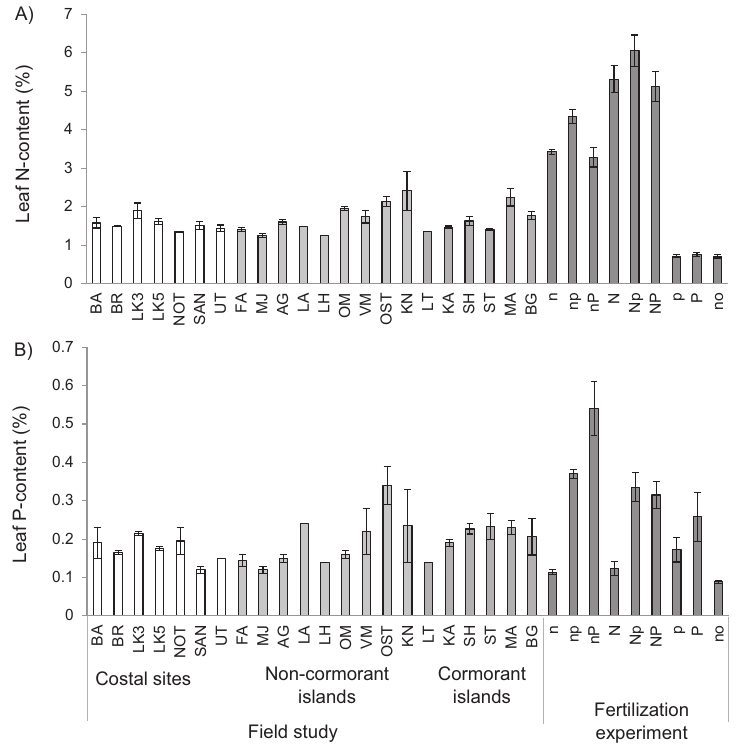
Figure 3. Lythrum salicaria leaf N- and P-contents collected on field costal field sites, non-cormorant islands, abandoned and active cormorant islands and from fertilization pot experiment (medium (n and p) hand high (N and P) level of N and P fertilization and no fertilization